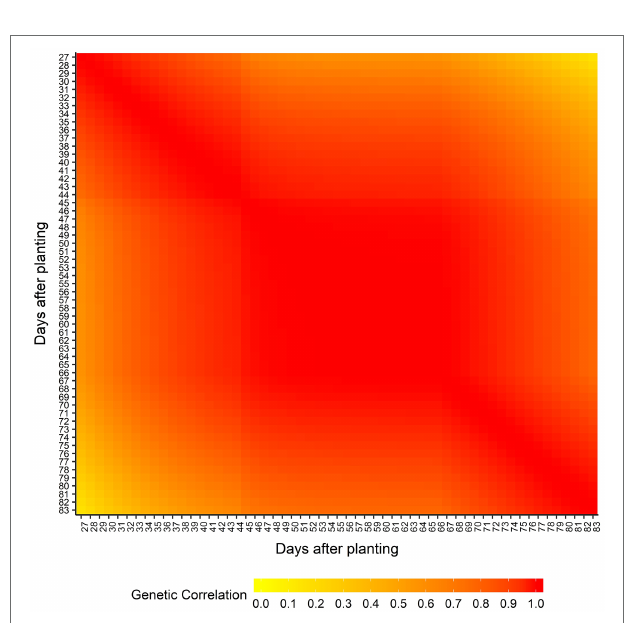
FIGURE 4 | Estimated genetic correlation of above-ground biomass between days after